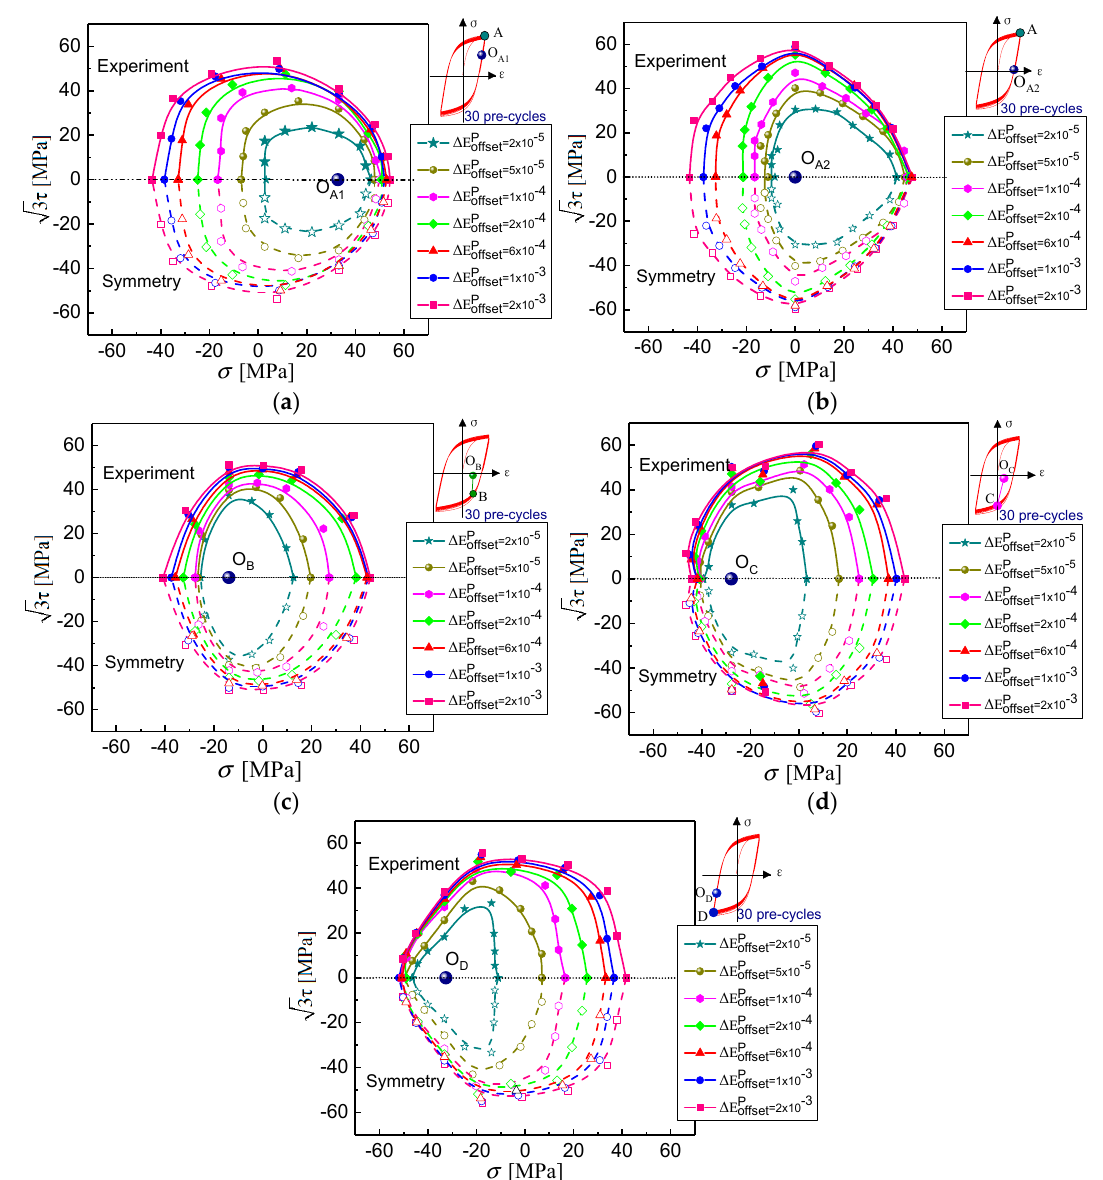
Figure 11. Subsequent yield surface at five different unloading cases from tension to compression transient after 30 tension-compress pre-cycles by experiments. ( a ) unloaded from A to O A1 ; ( b ) unloaded from A to O A2 ; ( c ) unloaded from B to O B ; ( d ) unloaded from C to O C ; ( e ) unloaded from D to O D .